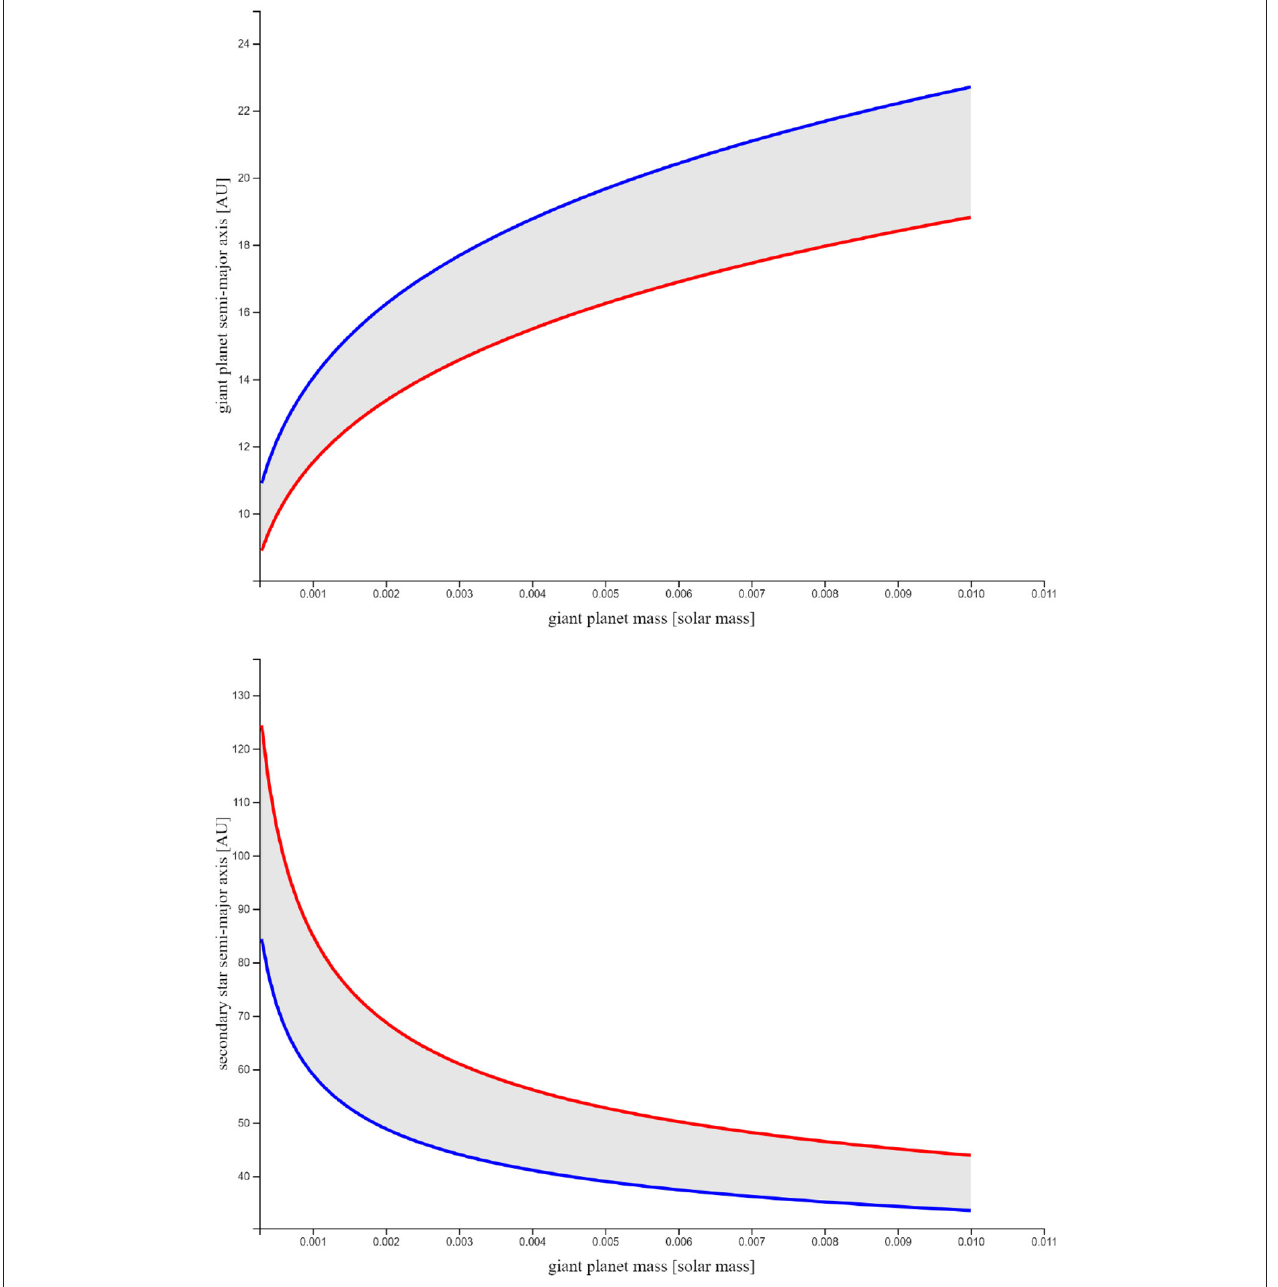
FIGURE 5 | Same as Figure 3 but for the variation of the giant planet’s mass (x-axis) vs. the variation of the semi-major axis either of the giant planet (Upper) or of the secondary star (Lower) in the y-axes.